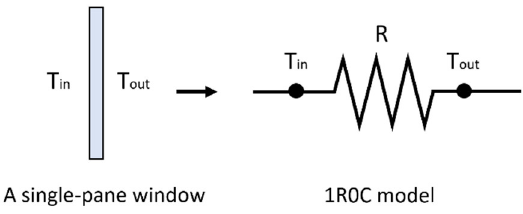
Figure 2. RC model for a general single-pane window.